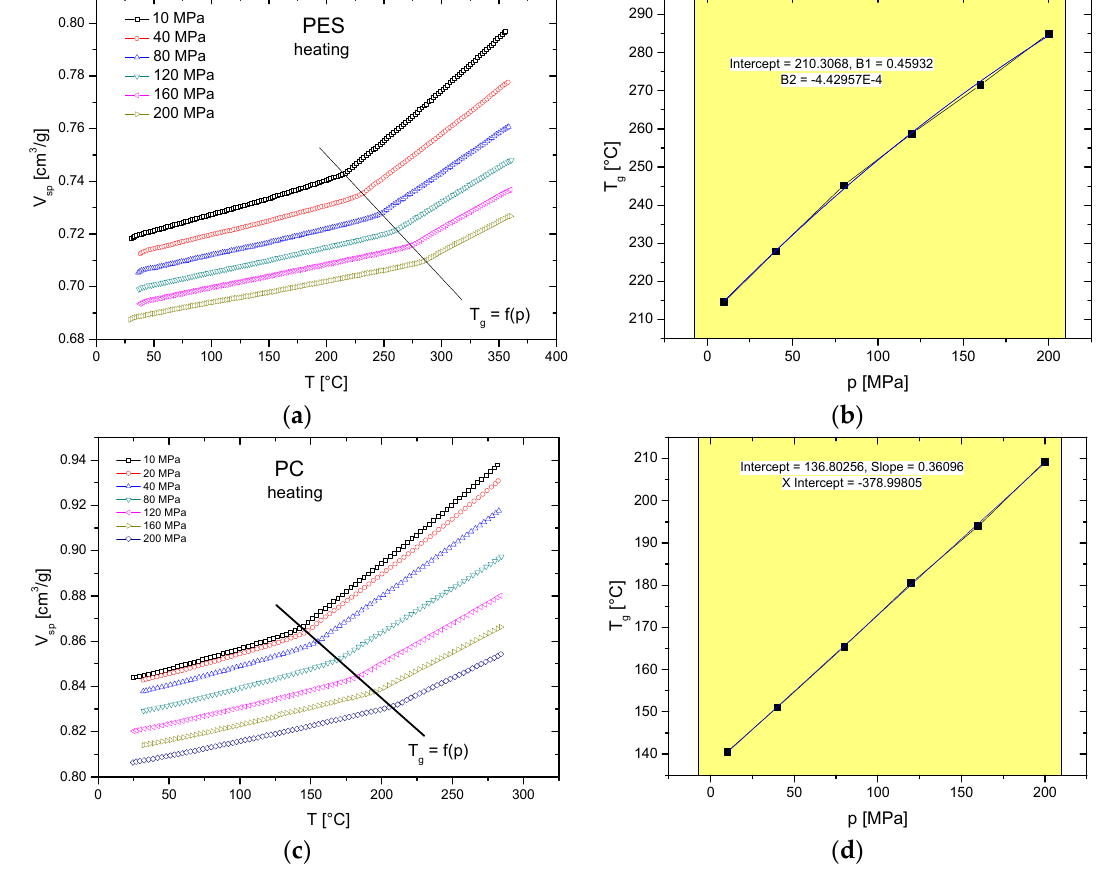
Figure 2. Pressure ‐ dependent glass transition of ( a , b ) PES 4100P and ( c , d ) PC Lexan 141: ( a , c ) isobars; ( b , d ) T g s in dependence on pressure and corresponding fits. Table 2. Glass transition temperatures (in °C) determined from isobars. p = Fit Parameters